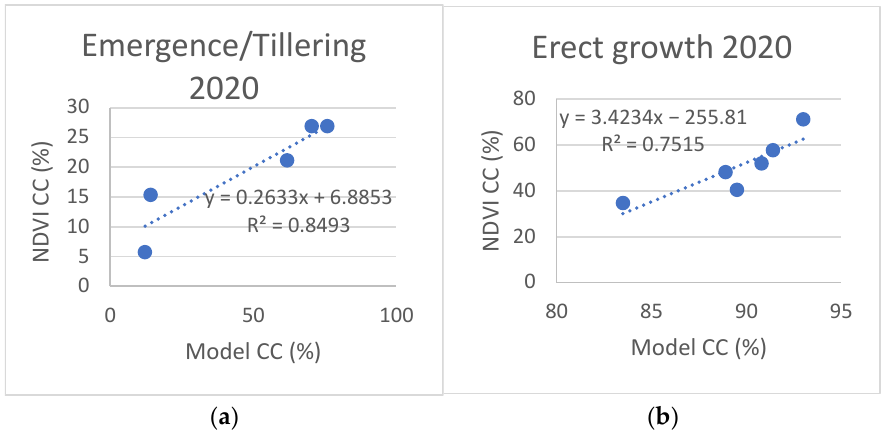
Figure 8. Comparison between NDVI and model-based canopy cover for emergence/tillering ( a ) and erect growth ( b ) of winter wheat, 2020.